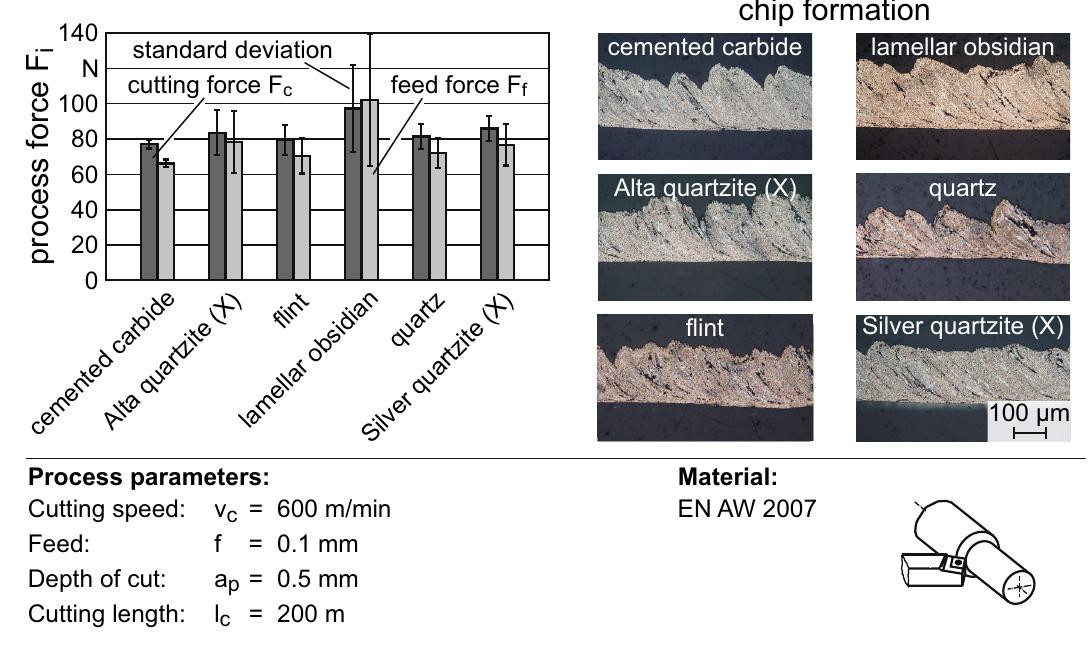
Fig. 21 Process forces and chip formation using rock inserts by machining